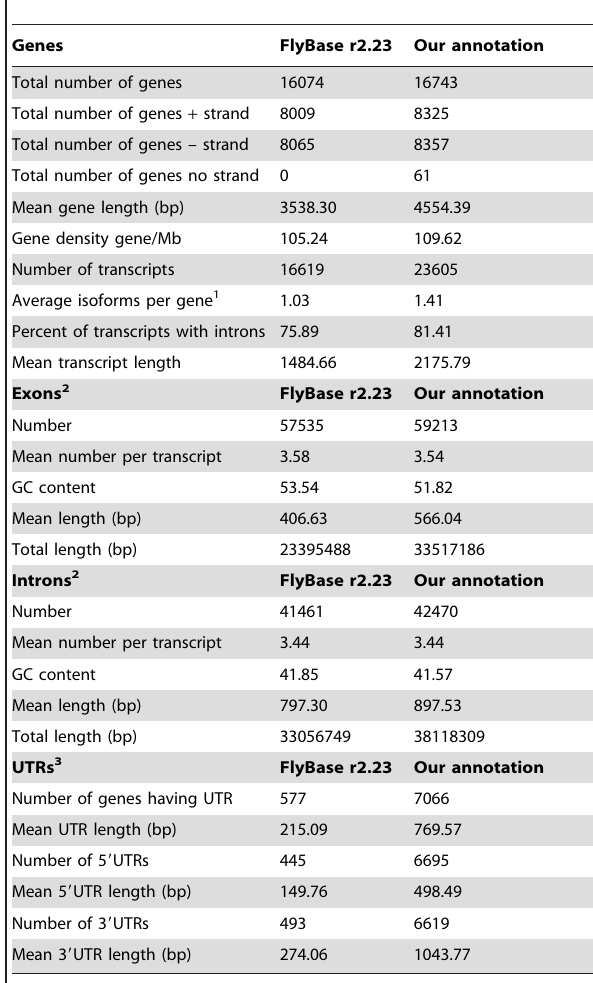
Table 2. Comparison of our annotation vs. the FlyBase annotation r2.23.